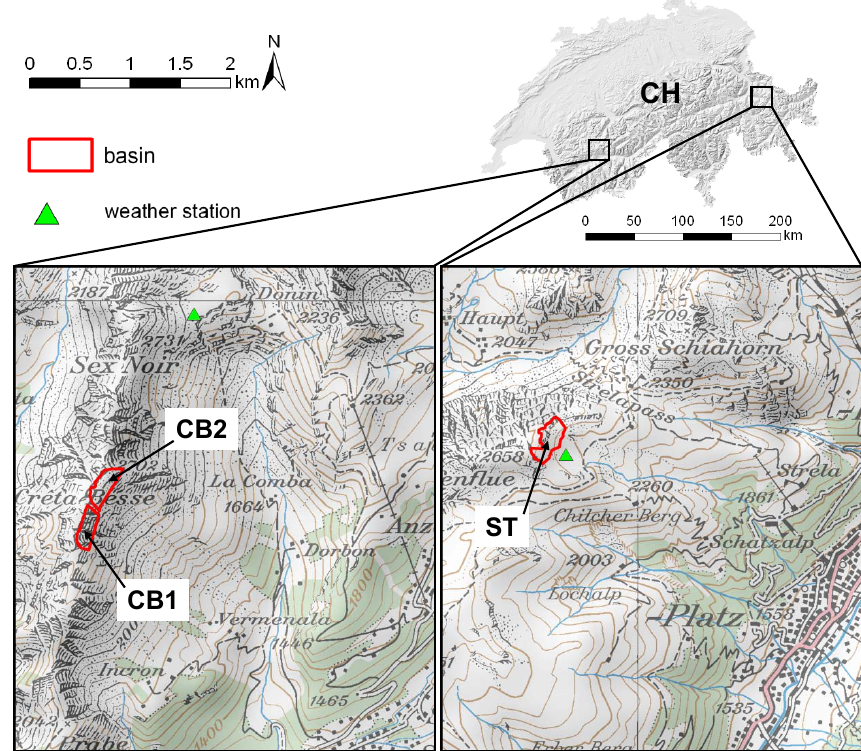
Fig. 1. Field sites Vallée de la Sionne (left) and Steintälli (right). In red are marked the exact location of the analysed basins CB1, CB2 and Fig. 1: Field sites Vall´ee de la Sionne (left) and Steint¨alli (right). In red are marked the exact location of the analyzed basins ST, and in green the location of the weather stations. Pixmaps © 2013 swisstopo (5704 000 CB1, CB2 and ST and in green the location of the weather stations. Pixmaps© 2013 swisstopo (5704 000 000).